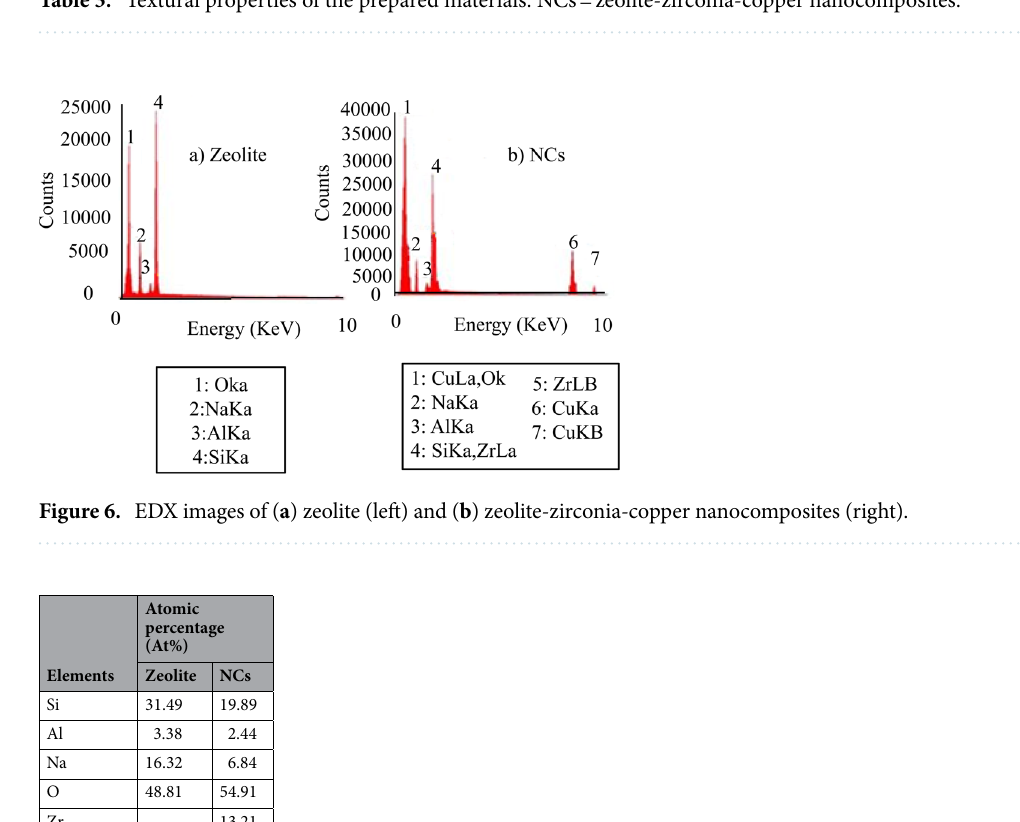
Table 3. Textural properties of the prepared materials. NCs = zeolite-zirconia-copper nanocomposites.